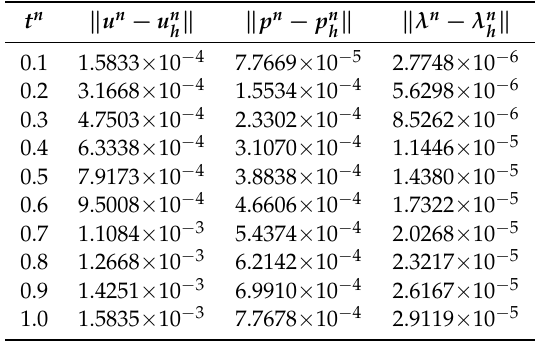
Table 1. Discrete errors with time steps for Example 1, nb = 2, h = 1/64, δ t = 0.1.